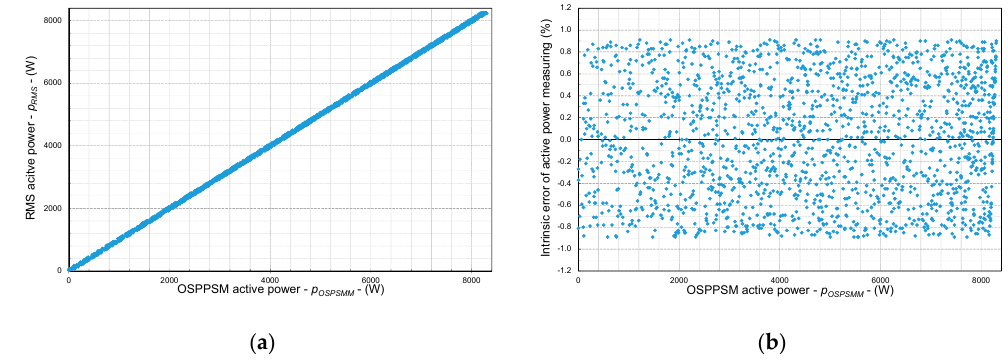
Figure 10. PF meter test: ( a ) 30 A, OSPPSM vs. RMS PF. ( b ) 8 A, OSPPSM vs. RMS PF. ( c ) Intrinsic error of PF measuring, 8 A and 30 A.